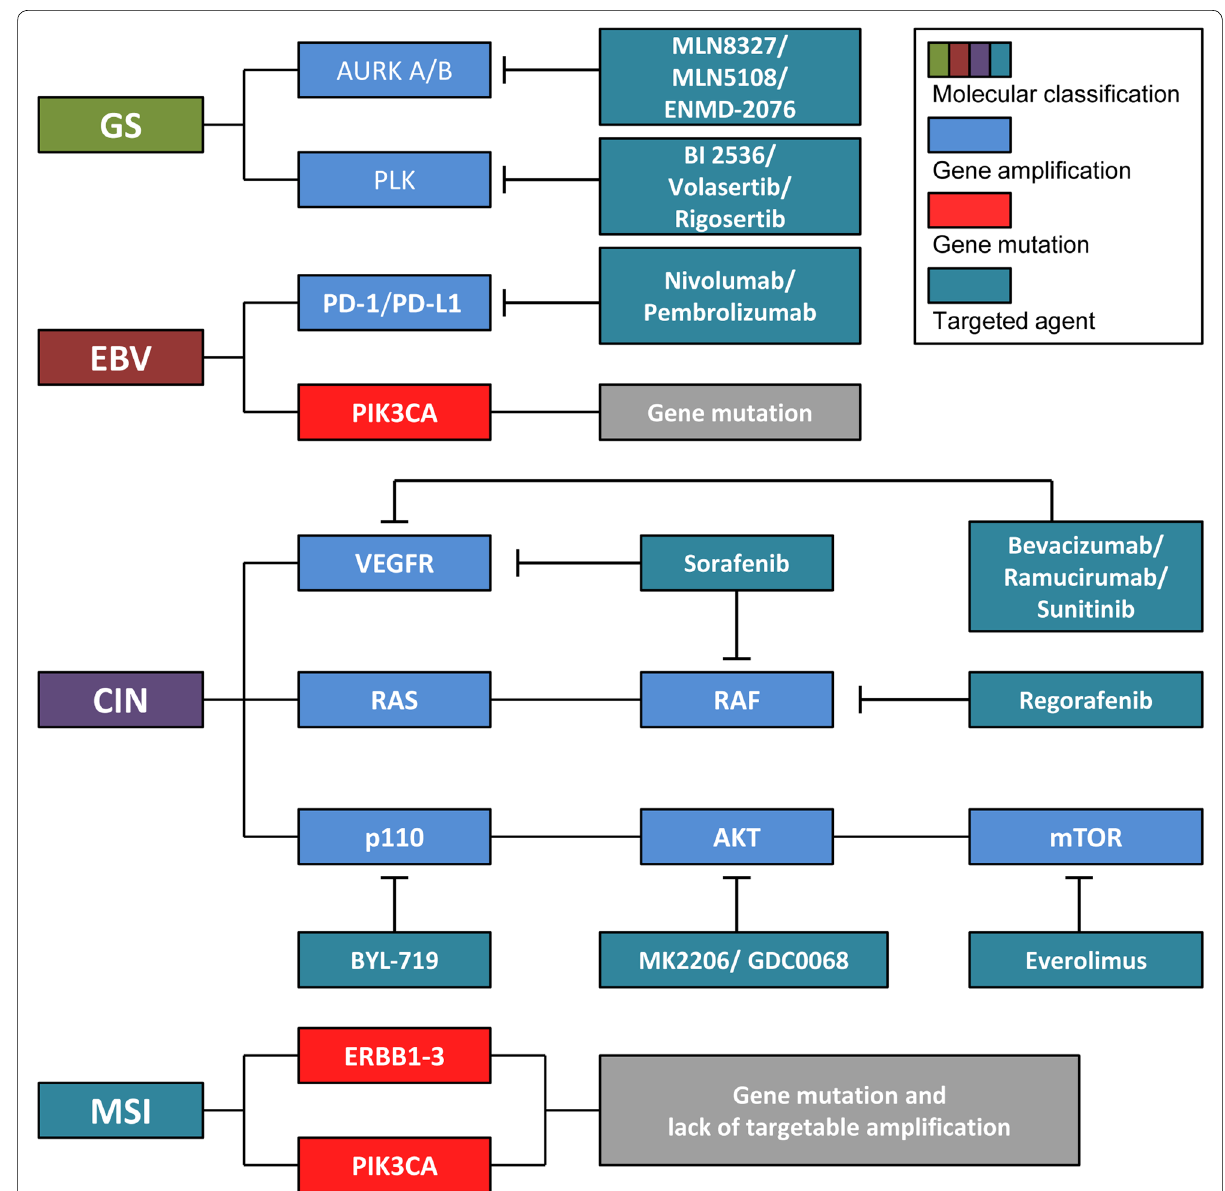
Fig. 2 The implications of the TCGA molecular classification of GCs for individualized therapeutics. AURK aurora kinase, PLK polo‑like kinase, VEGFR vascular endothelial growth factor receptor, AKT v‑akt murine thymoma viral oncogene homolog 1, mTOR mechanistic target of rapamycin, ERBB erb‑b2 receptor tyrosine kinase. Other abbreviations as in Fig.